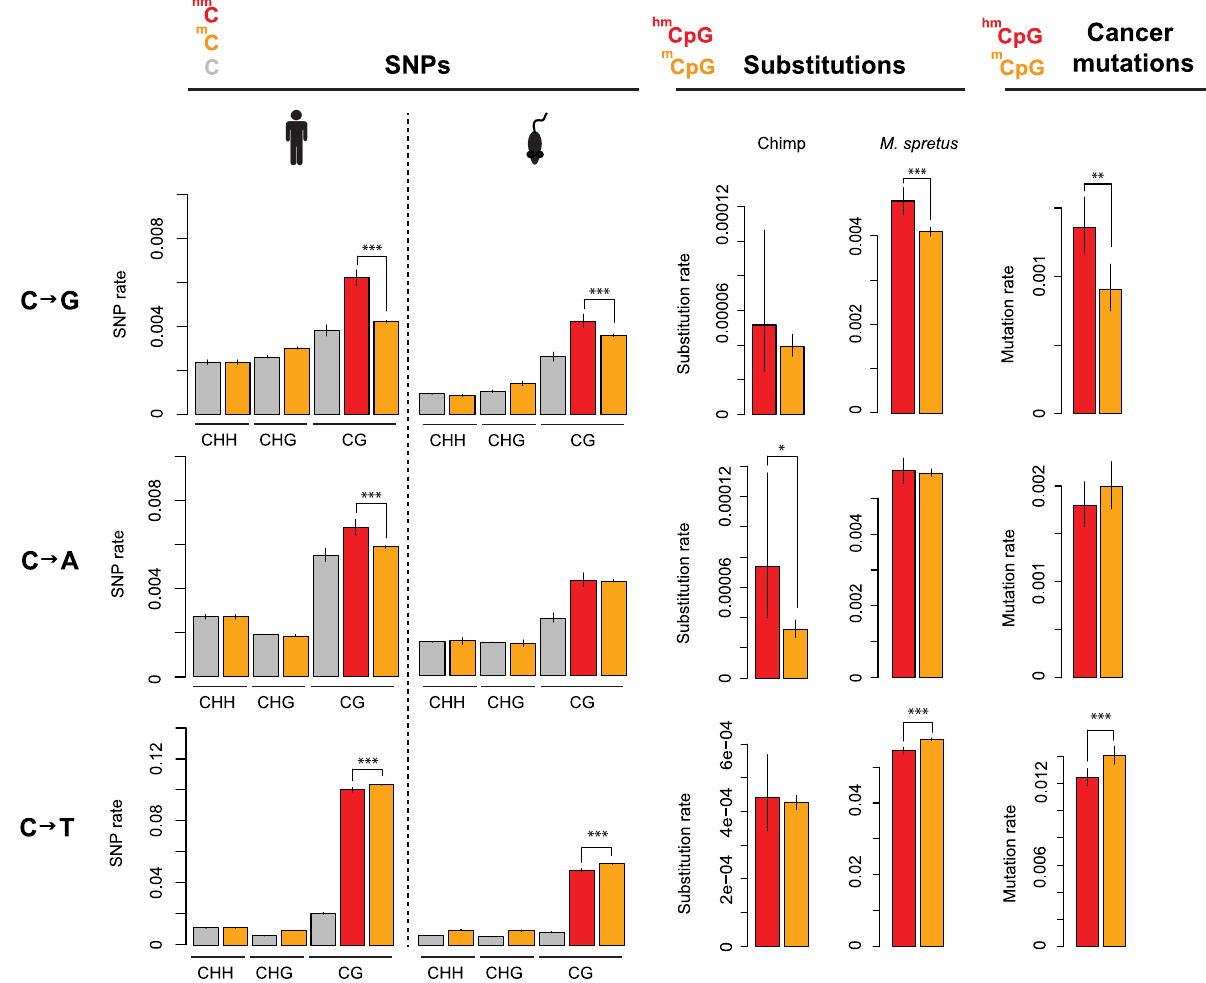
Figure 1. Evolutionary rates differ according to methylation state. Rates of cytosine loss are given as a function of methylation status (5hmC: red; 5mC: orange; C: grey), methylation context (CHH, CHG, CG; H=A/C/T) and evolutionary event (derived SNPs in human or mouse population; substitutions along the chimp or M. spretus lineage; somatic mutations in cancer genomes). Only significant differences between 5hmC and 5mC sites in a CpG context are highlighted (***P , 0.001; **P , 0.01; *P , 0.05). Error bars are 95% confidence intervals, calculated using Wilson’s interval score for single proportions.